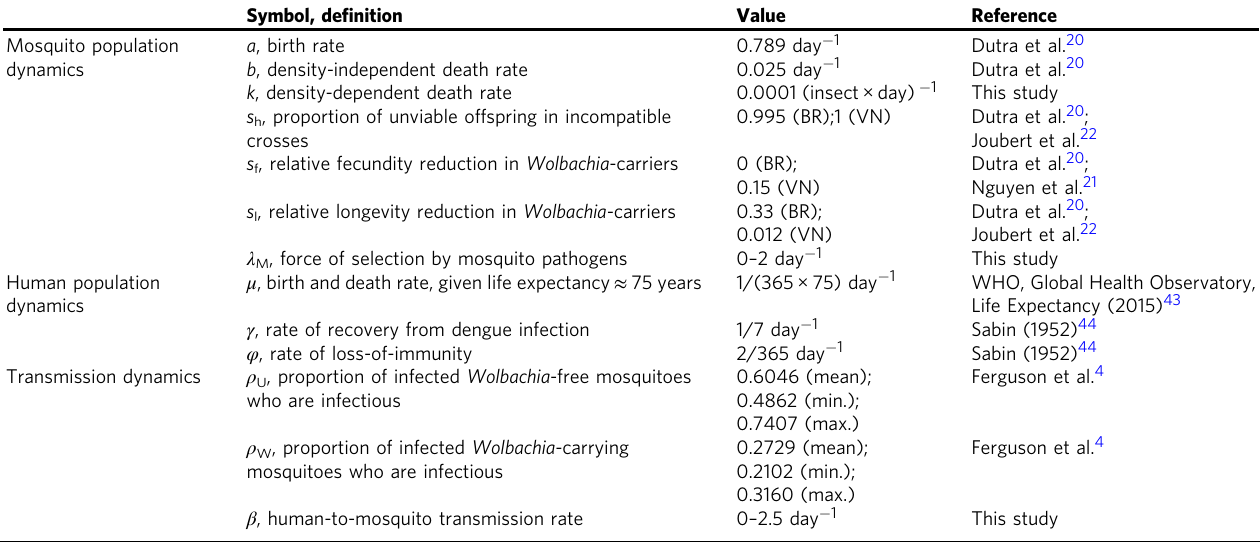
Table 2 Parameters for Wolbachia invasion and dengue transmission